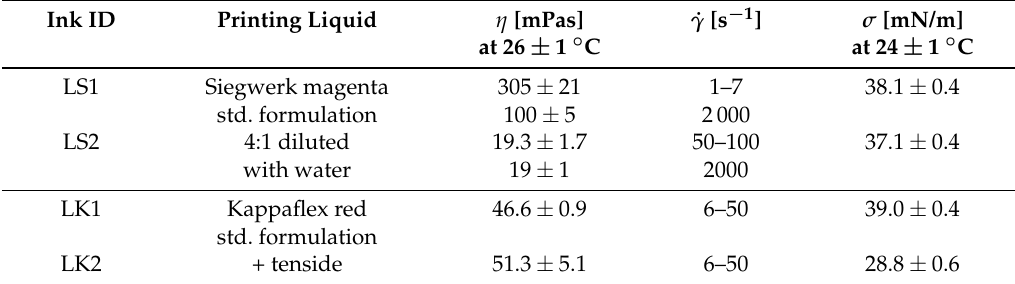
Table 2. Viscosities and surface tensions of the printing liquids.